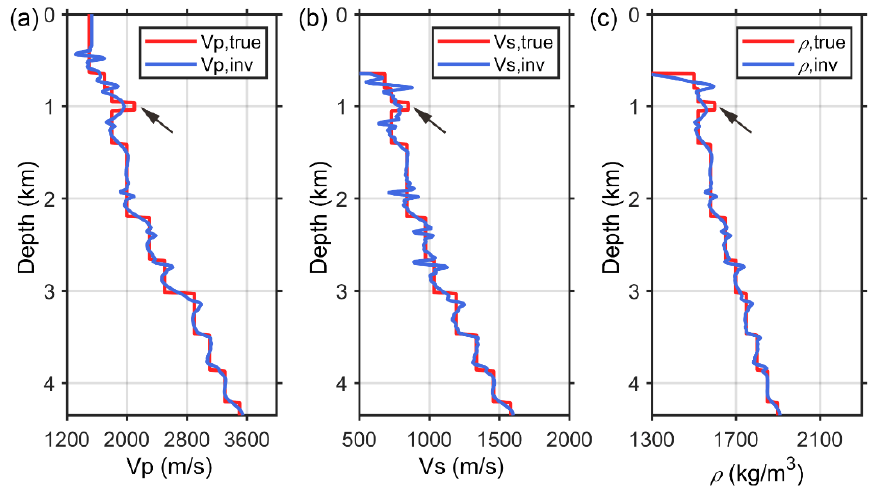
Figure 7. The inverted models from the noise-free data using the conventional AVO method: ( a ) P- wave velocity, ( b ) S-wave velocity, and ( c ) density. The black lines indicate the stratigraphic hori- zons and the red lines indicate the faults. The inverted stratigraphic horizons indicated by the black arrows do not agree well with the real ones.